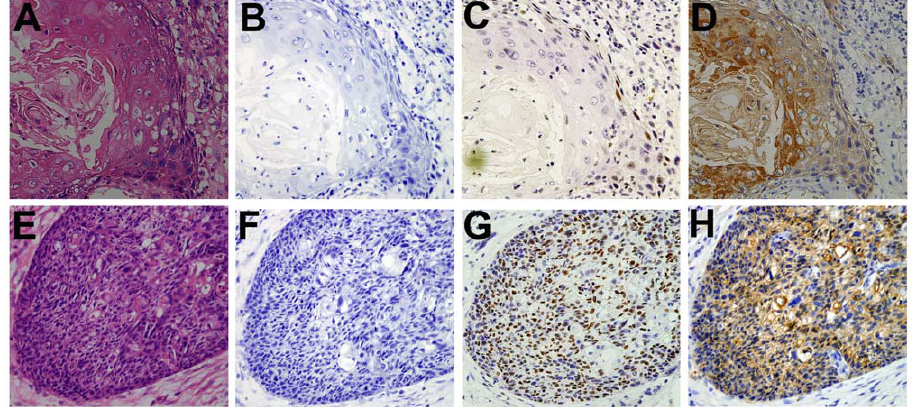
Figure 1. Two typical cases with low and high cyclin D1 expression were tested by cytokeratin stain. Figs. A–D: The low cyclin D1 expression case. A. HE stain (400cyclin D1 expression were tested by cytok D1 stain (400 case. P-CK stain (40000 cases. E–H: The high cyclin D1 expression case. E. HE stain (400cyclin D1 expression were tested by cytok D1 stain (400 6 ); H. P-CK stain (40000 6 ). doi:10.1371/journal.pone.0026399.g001 PLoS ONE |